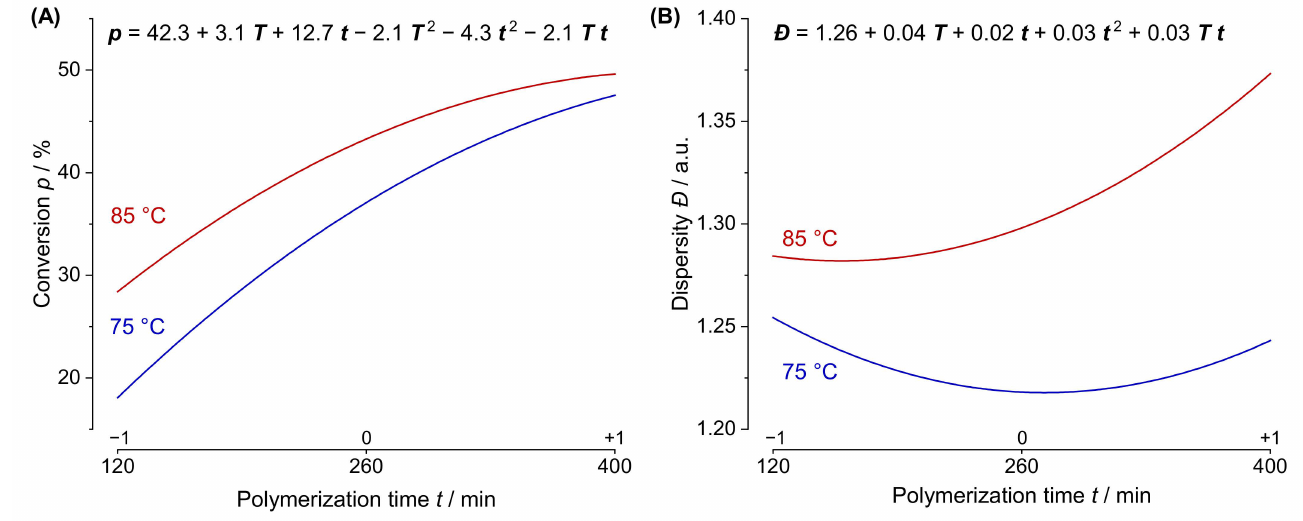
Figure 3. Illustration of two temperature–time interaction plots. The responses ( p in graph ( A ) and Ð in graph ( B )) are plotted against t for the temperatures of 75 ◦ C (blue line) and 85 ◦ C (red line), whilst the factors R M , R I , and w s are set to their center (0) level. The respective coded prediction models are additionally